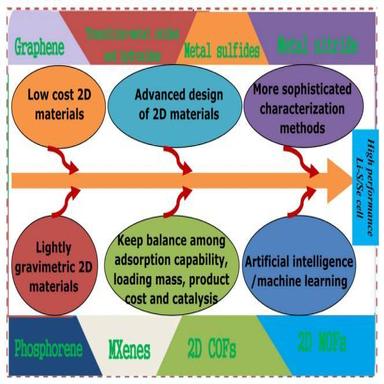
Thedetailedpossibleways forthedevelopmentof2Dmaterials inhighperformanceLi-S/Secells.